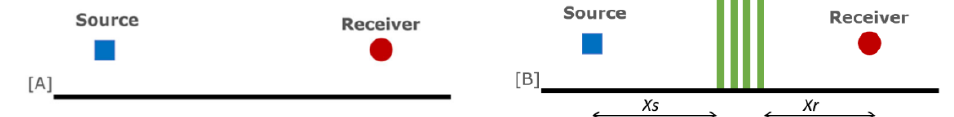
Figure 3. Sectional scheme of the equipment location during the measurements without ( A ) and with ( B ) the metamaterial acoustic barrier.